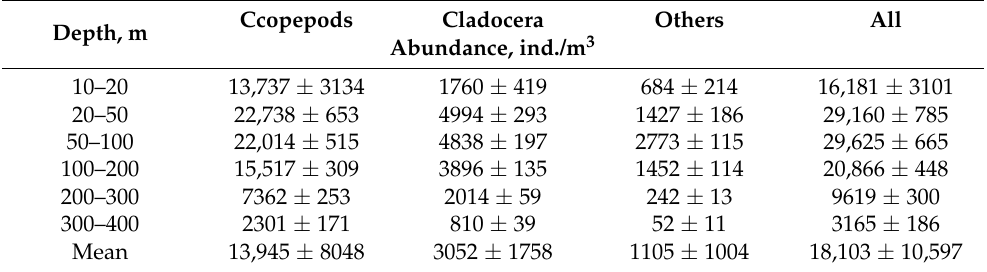
Table 7. Abundance of zooplankton in the eastern part of the Middle Caspian, May 2016.